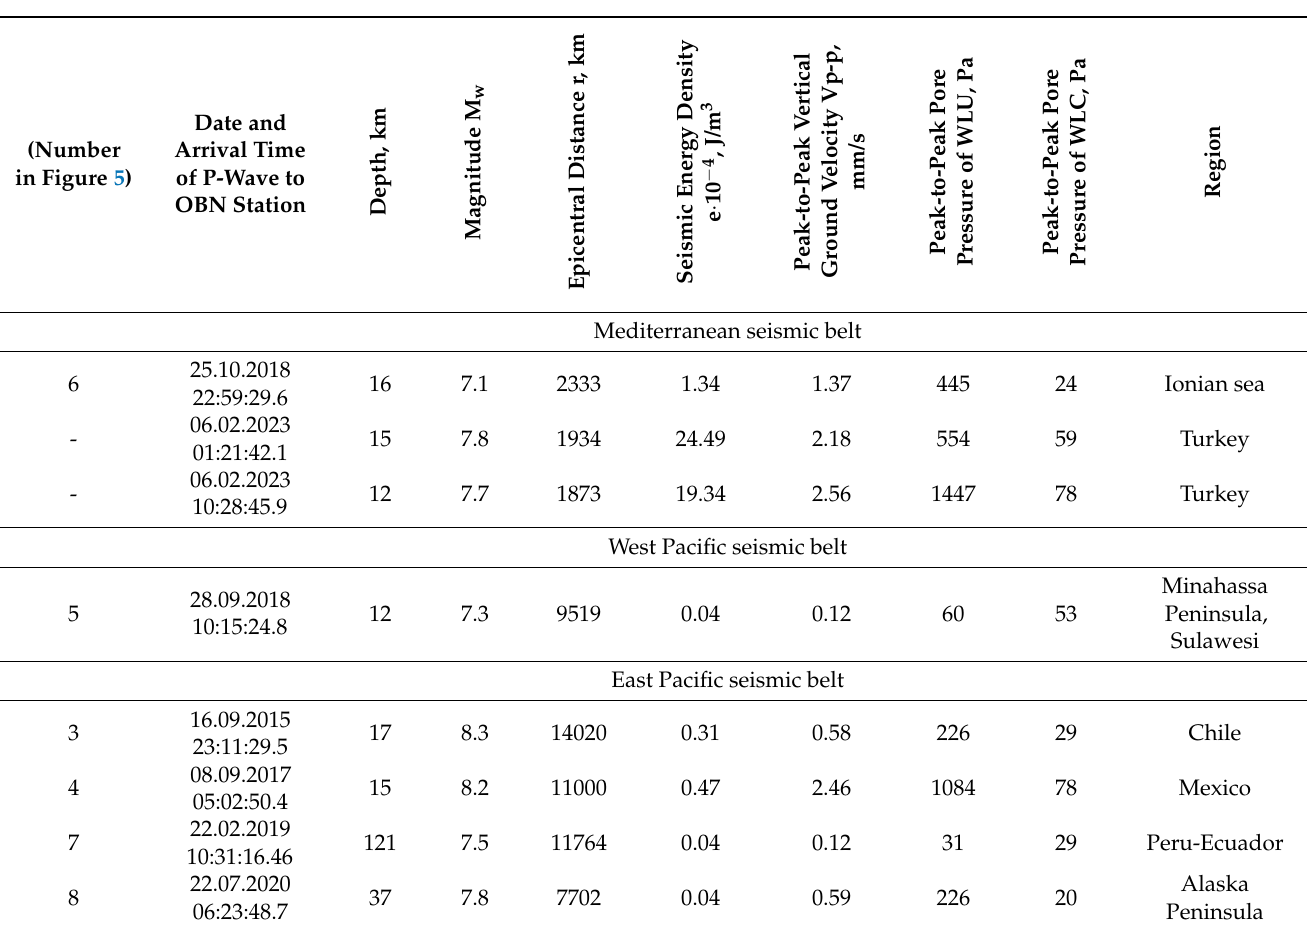
Table 2. Earthquakes with synchronous hydrogeological responses in the confined and weakly confined